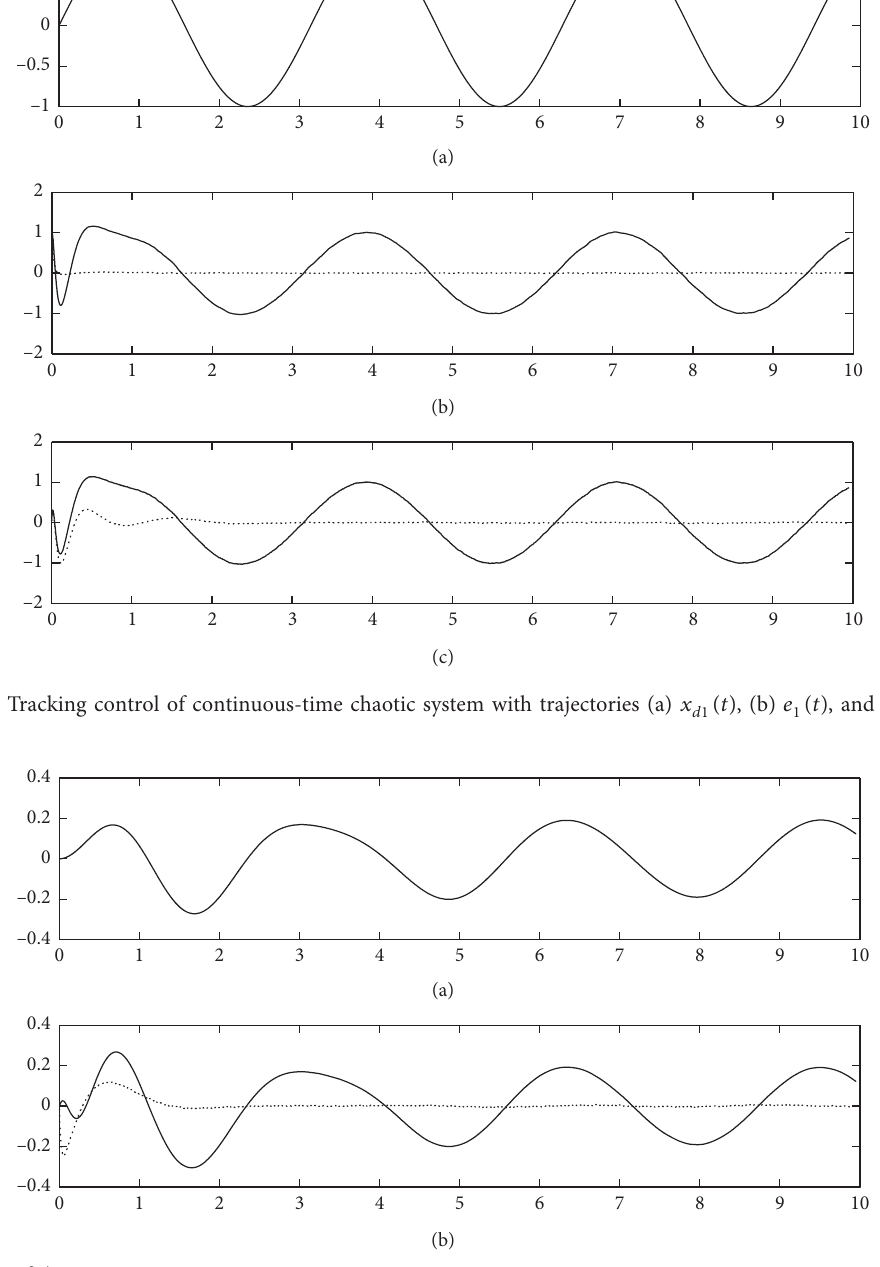
( t ) , (b) e ( t ) , and (c) x ( t ) d 2 h 2 2